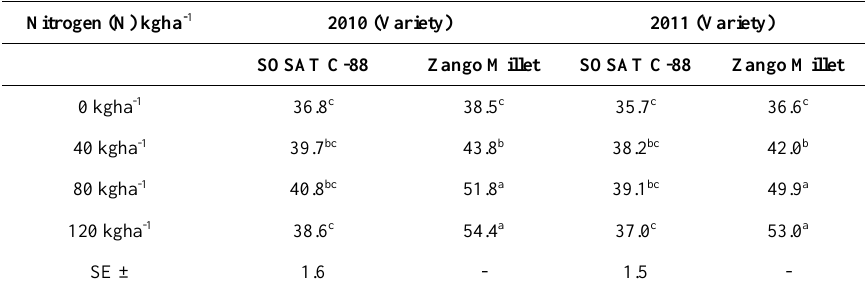
Table 5. Interaction effect of varieties, nitrogen levels on Panicle length (cm) during 2010 and 2011cropping seasons